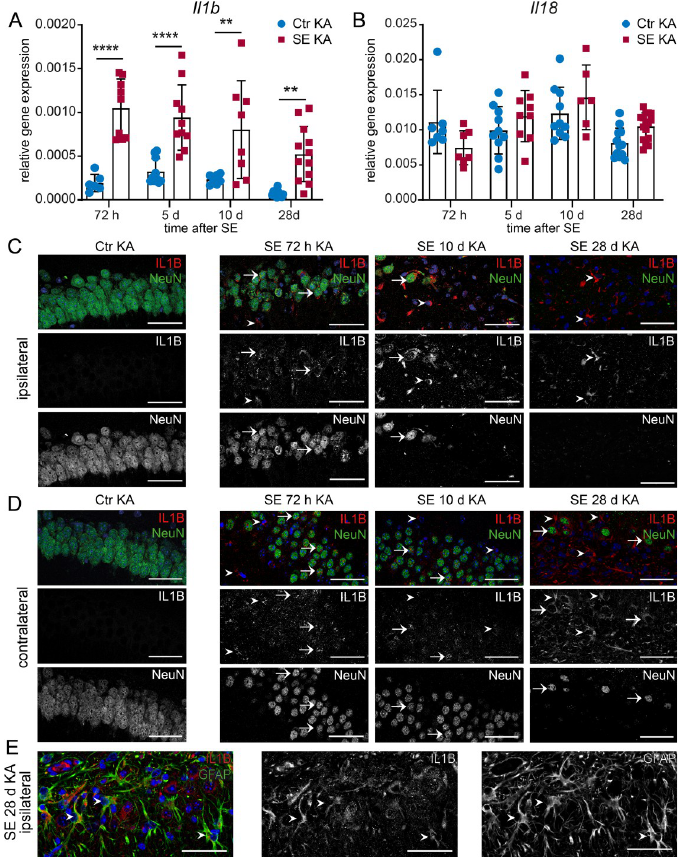
Fig 3. mRNA and protein expression levels of Interleukin 1 beta (IL1B) are augmented in the CA1 region over a period of 4 weeks after kainic acid-induced SE. ( A ) IL1b and ( B ) Il18 mRNA levels ( ΔΔ C t method) are determined 72 h (n � 4), 5 d (n � 5), 10 d (n � 4) and 28 d (n � 6) after kainic acid-induced SE compared to non-SE control animals (Ctr KA) with 2way ANOVA followed by Sidak’s post hoc test. Asterisks indicate significant differences between groups (control vs. SE): � p < 0.05, �� p < 0.01, ��� p < 0.001, ���� p < 0.0001. Detailed statistical values are found in S2 Table . The ubiquitously expressed β -actin is used as housekeeping gene. Immunohistochemistry of ( C ) ipsilateral (KA- injected) as well as ( D ) contralateral hemisphere shows single IL1B granula (red) within NeuN-postive cells (green) at 72 h post-SE (arrows). Additionally, very few non-neuronal IL1B positive cells are found (arrowheads). 10 d post-SE IL1B immunoreactivity is detected in neurons (arrows) and non-neuronal cells expressing IL1B, observed mainly in areas with vast neuronal cell loss. At 28 d post-SE, a high number of cells are IL1B positive (arrowheads) including also remaining NeuN positive cells in the contralateral hemisphere (arrows). In non-SE control animals (Ctrl KA), expression of IL1B is not detected (leftmost). Scale bars: 50 μ m. DAPI for nucleic acid counterstain (blue). Il18 gene expression was not significantly altered in this model ( Fig 3B ). A granular expres- sion of IL1B was present within neuronal somata as well as an increasing expression on non-neuronal cells at all analysed timepoints with the strongest expression after 28 days in the dorsal CA1 region ( Fig 3C and 3D ). Interestingly, in the chronic period, an intense IL1B expression was present on non-neuronal cells including astrocytes ( Fig 3E ). In addi- tion to a large inter-individual variance in seizure frequency, the median frequency of sei- zure sum of three consecutive days shows minor differences between the different time points showing at both models ( S3A and S3B Fig ). A direct inverse correlation between sei- zure frequency and gene expression was observed for Interleukin 1 beta ( Il1b ) in the KA- induced model ( S3B Fig and S2 Table ).